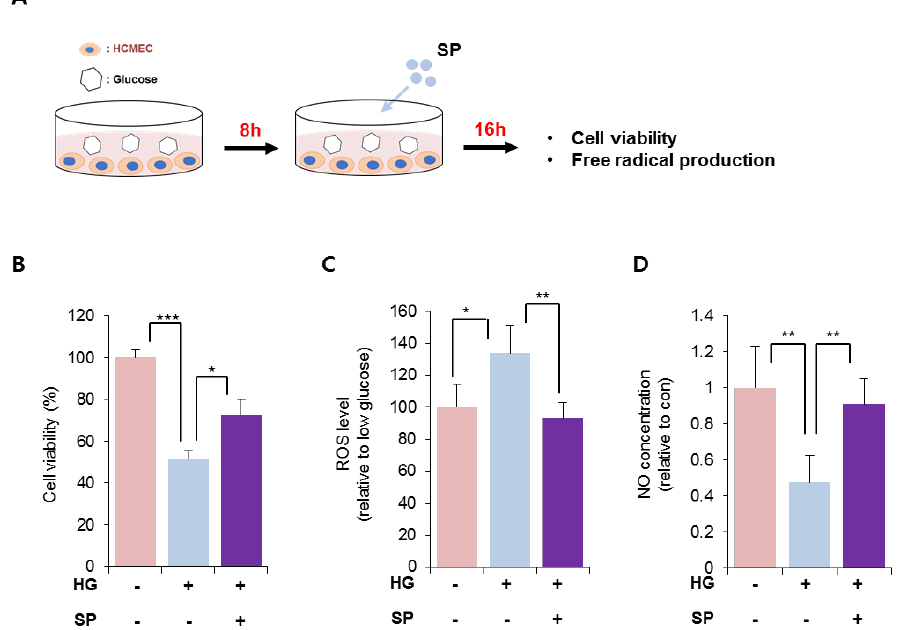
Figure 2. SP treatment restores the cellular activity of cardiac microendothelial cells with inhibition of the imbalance of free radicals. ( A ) Experimental scheme for glucose and SP treatment. ( B ) Cell viability of CMECs was evaluated via WST-1 assay. ( C , D ) Free radical generation was evaluated. ( C ) ROS and ( D ) NO production was represented relative to that in normal condition. Values of p < 0.05 were considered significant (* p < 0.05, ** p < 0.01, *** p < 0.001). The data are expressed as the mean ± standard deviation of three independent experiments. SP, substance-P; HG, high glucose; CMECs, cardiac microvascular endothelial cells; ROS, reactive oxygen species; NO, nitric oxide; con,